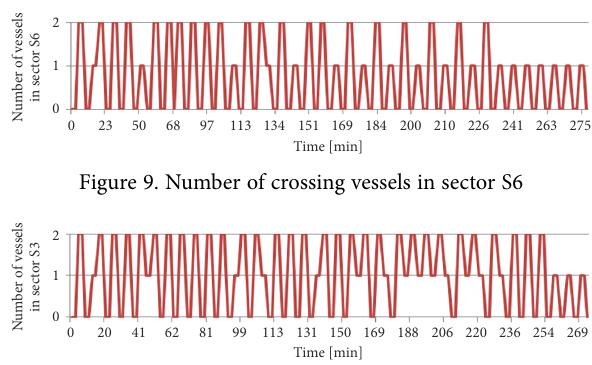
Figure 10. Number of crossing vessels in sector S3